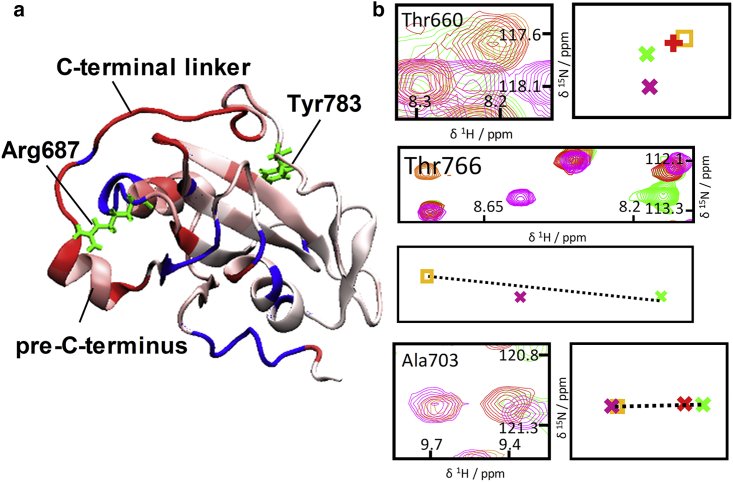
NMR data indicating a specific effect of the Arg687Trp mutation on the C-terminal-linker-dependent pathway. (a) Depiction of the cSH2 domain is colored to illustrate the degree of chemical shift perturbation for R687W-NSH2CSH2-pY783 relative to NSH2CSH2-pY783 mutants: white (no perturbation) to red (strong perturbation); blue, insufficient data. (b) Superposition of 1H,15N-HSQC spectra recorded at 600 MHz and corresponding schematic representations of crosspeak centroids are shown (color scheme as in Fig. 3). The Arg687Trp mutation leads to a perturbation for junction residue Thr660. The crosspeaks for residues such as Ala703 that are associated with the C-terminal-linker-independent allosteric pathway are barely shifted. Larger CSPs are observed for residues exemplified by Thr766 that are associated with the C-terminal-linker-dependent pathway. Additional examples are shown in Fig. S11.